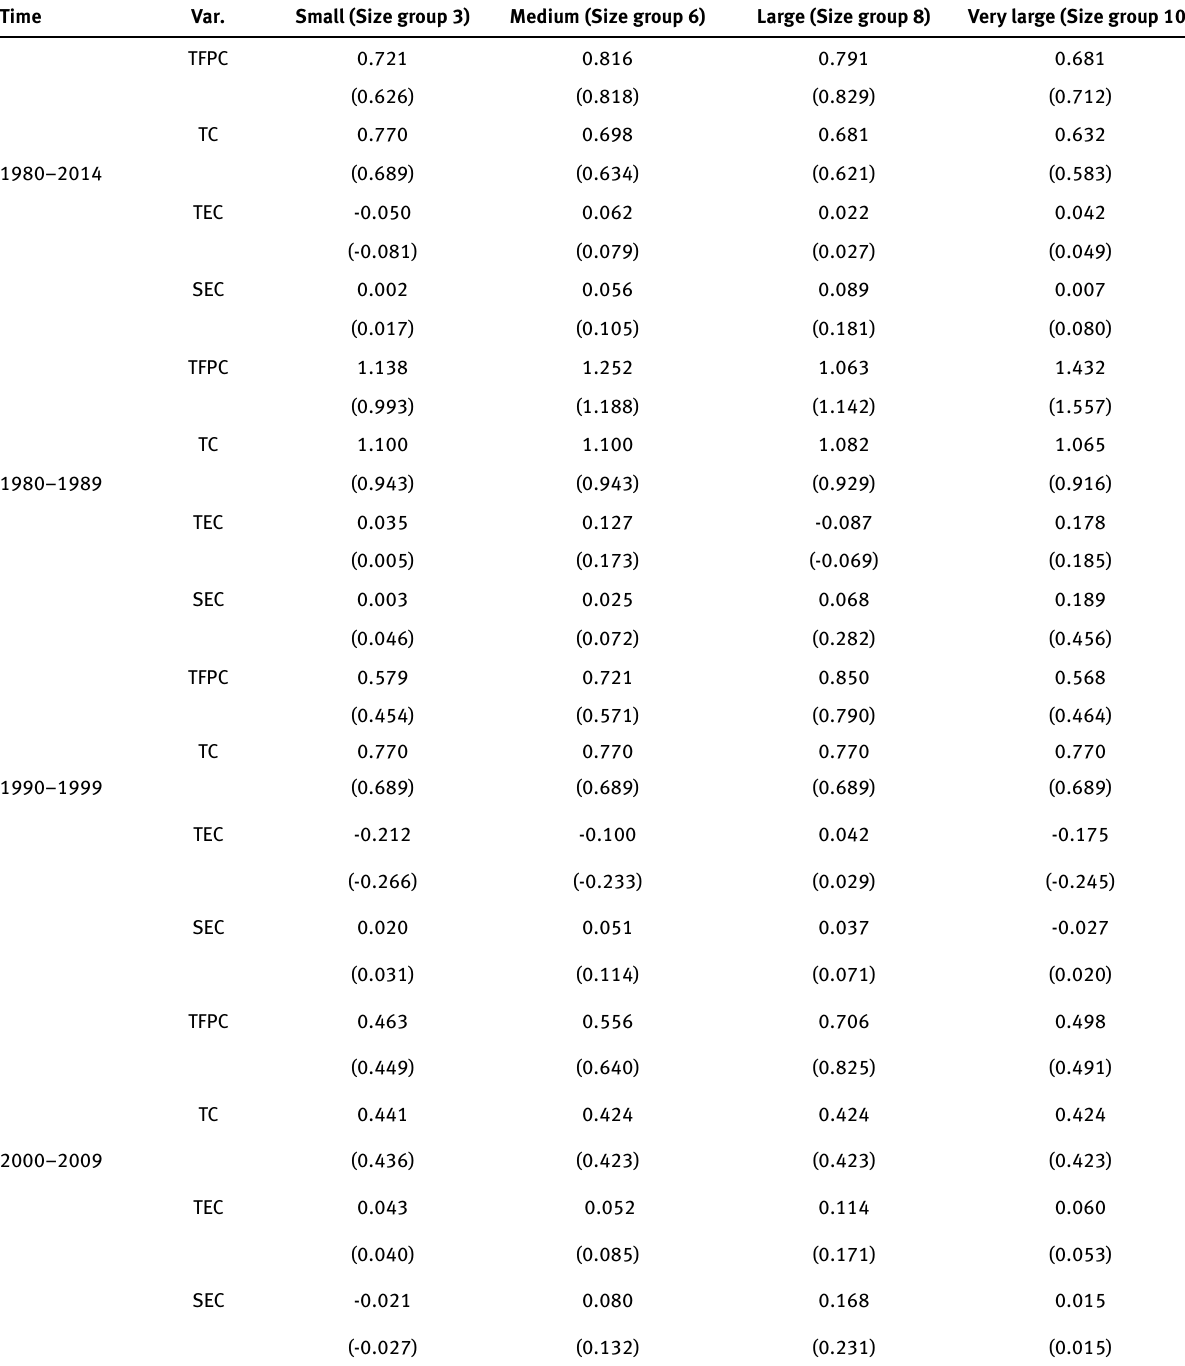
Table 5: Mean TFP change of various size classes using Model 1a and Model 2a